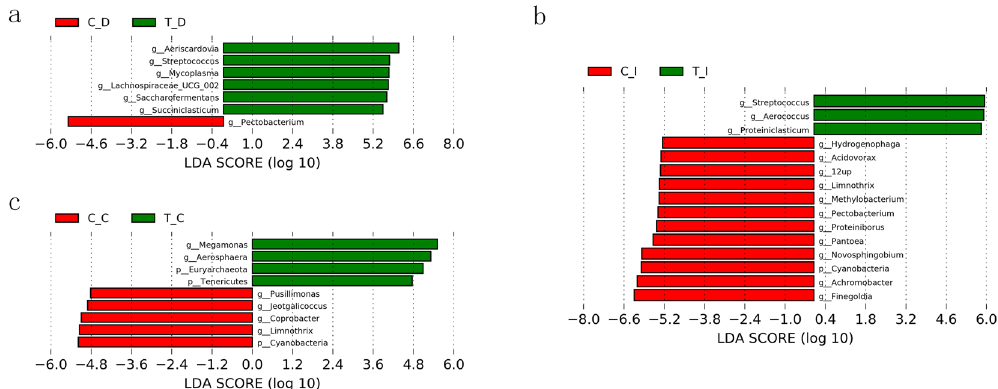
Figure 3. Histogram of the Liner discriminant analysis (LDA) coupled with effect size measurements identified the most differentially abundant genera between the duodenum ( a ), ileum ( b ), and cecum ( c ) of RLF and RPMF ducks. The RLF duck enriched genera are indicated with a negative LDA score, and the genera enriched in the RPMF ducks are indicated with a positive score. The criteria of the LDA score for discriminative features was > 4.0, and the alpha value for the factorial Kruskal—Willis test among classes was <